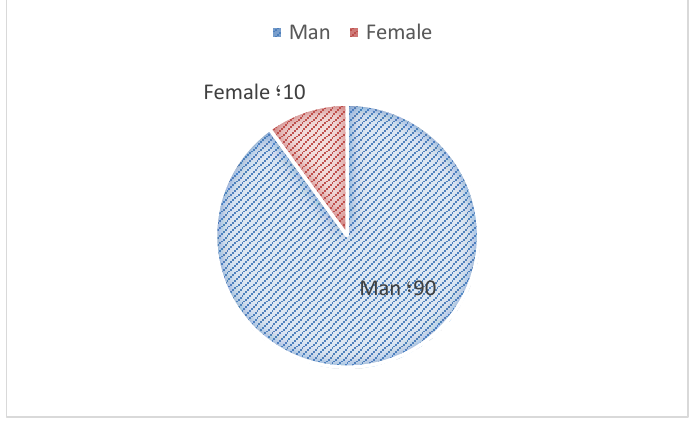
Fig. 1. Gender of respondent